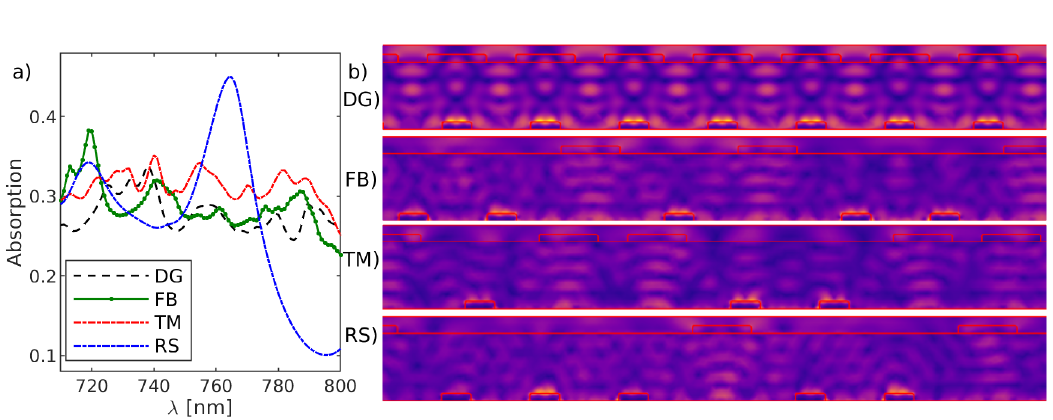
Figure 9. ( a ) simulated spectral response of the active layer’s optical absorption in structures with a periodic double grating (DG) along with double gratings based on Fibonacci (FB), Thue–Morse (TM) and Rudin–Shapiro (RS) sequences; ( b ) simulated electric field distributions at an operating wavelength of 764 nm for all of the mentioned